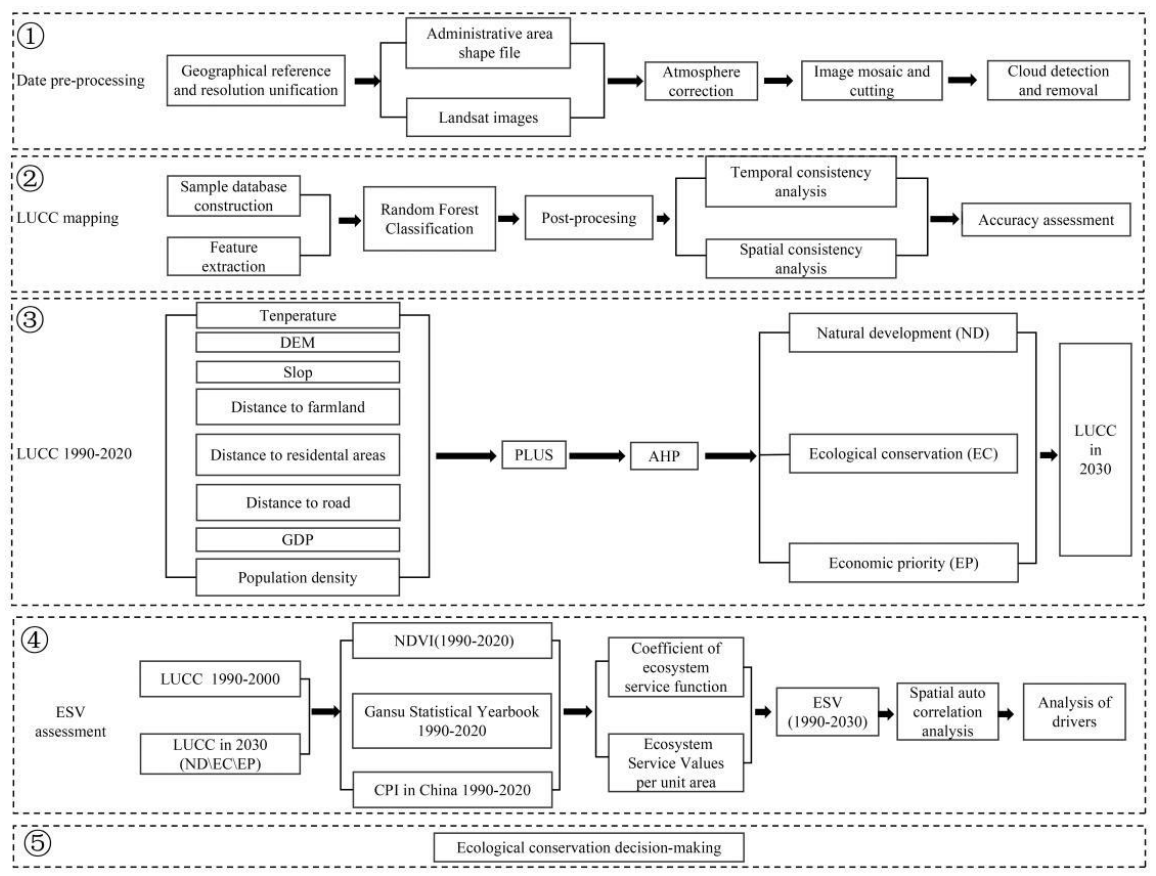
Figure 2. Framework of this study.